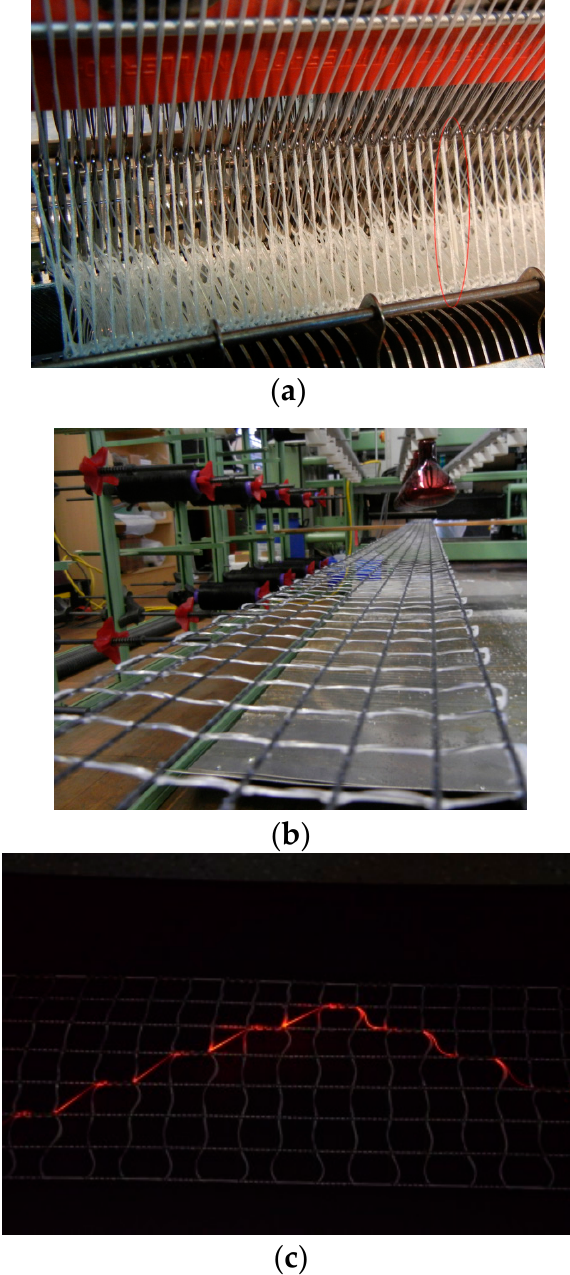
Figure 2. Wrap knitting machine that can simultaneously process alkaline-resistant glass and optical